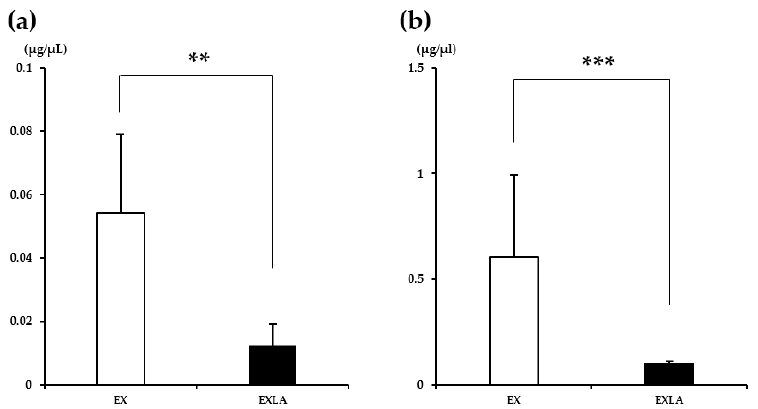
Figure 6. Glycogen content in the liver and muscle after exercise. ( a ) Muscle glycogen content; ( b ) liver glycogen content. EX, exercise control group; EXLA, exercise with lactate intake group. Values represent the mean ± standard deviation ( n = 8). ** p < 0.01, *** p < 0.001.